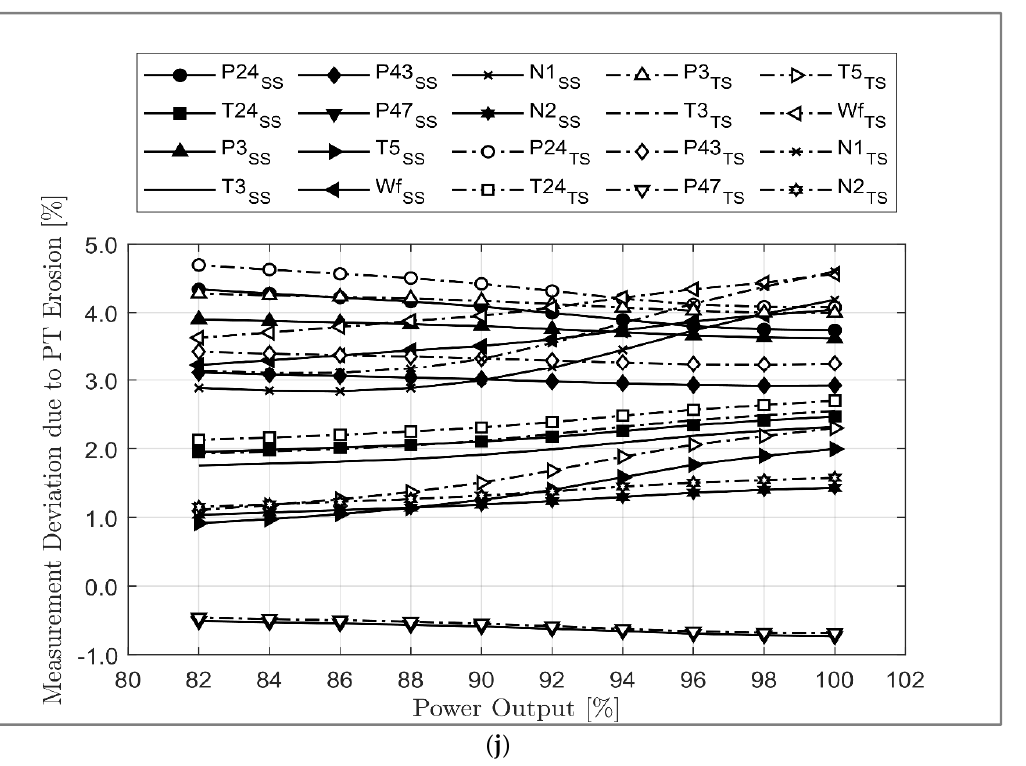
Figure 9. Deviation of component measurement parameters: ( a ) LPC fouling, ( b ) HPC fouling, ( c ) HPT fouling, ( d ) LPT fouling, ( e ) PT fouling, ( f ) LPC erosion, ( g ) HPC erosion, ( h ) HPT erosion, ( i ) LPT erosion, ( j ) PT erosion.